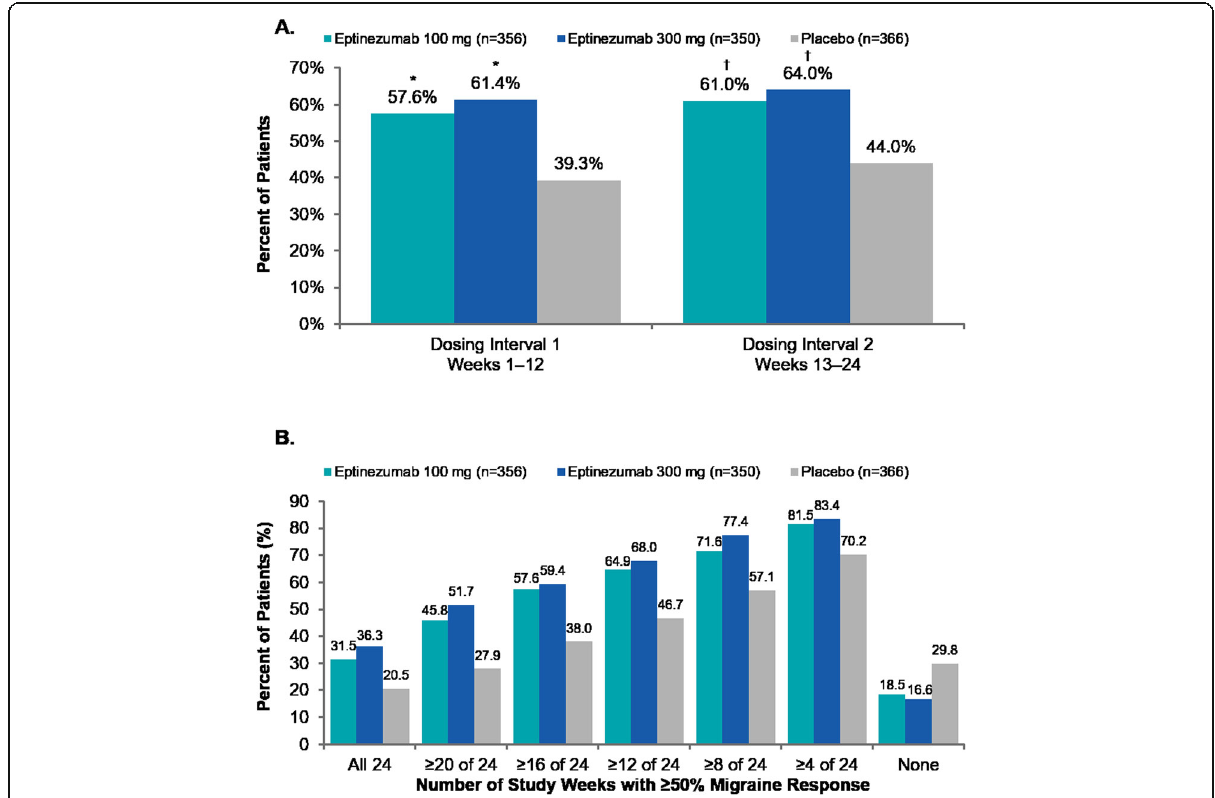
Fig. 3 ( a ) Rates of ≥ 50% migraine response by 12-week dosing interval and ( b ) cumulative 4-week intervals with ≥ 50% migraine response (efficacy population). *P < 0.001 vs placebo. † Nominal P < 0.001 vs placebo (analyses of migraine responder rates over weeks 13 – 24 were not formally tested per the predefined statistical